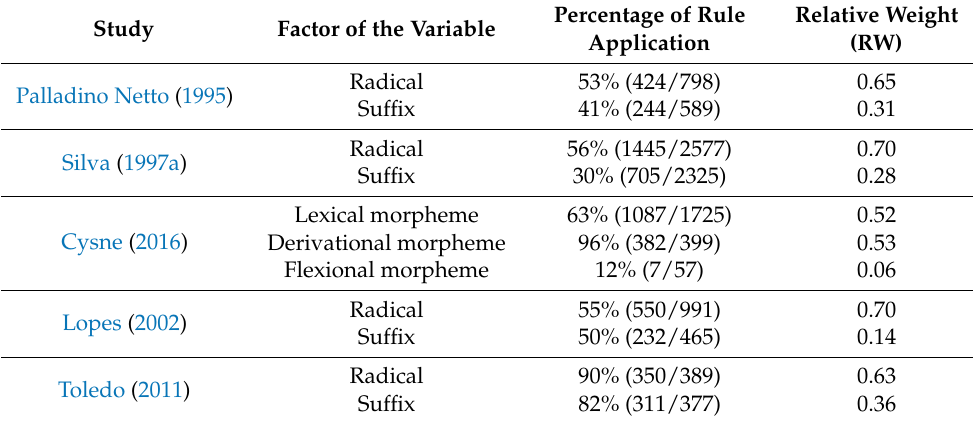
Table 6. Effects of the factors of the variable morphological